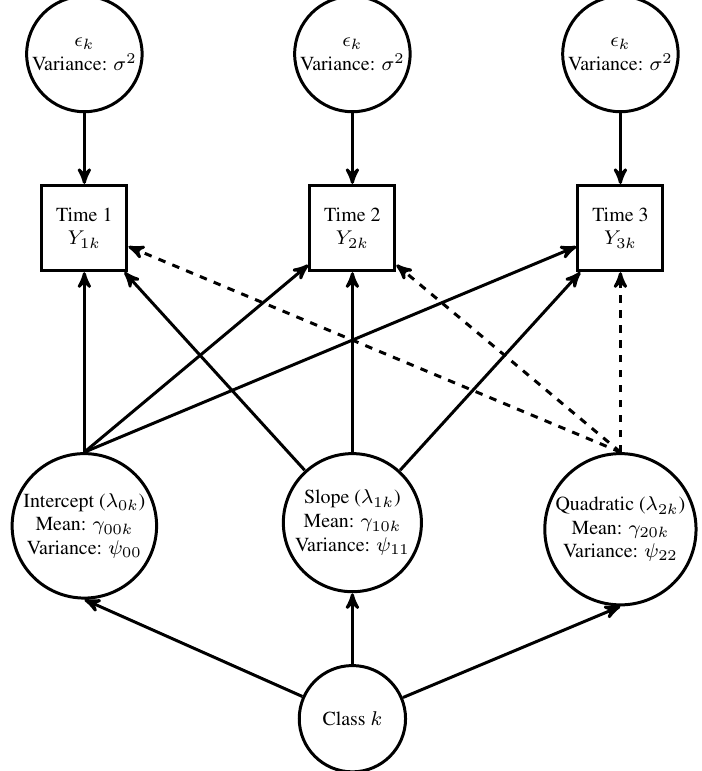
Figure 1. Conceptual diagram of the linear and quadratic growth mixture model with Level-1 subscripts removed. Coefficients for dashed lines were set to zero for the linear